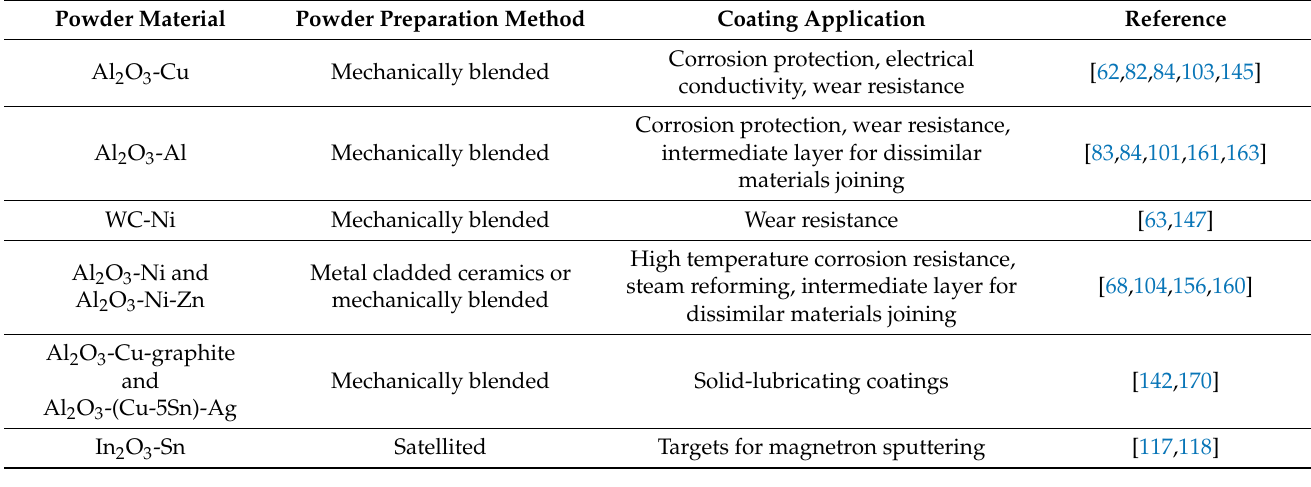
Table 3. Selected applications of the LPCS PRMMC coatings.